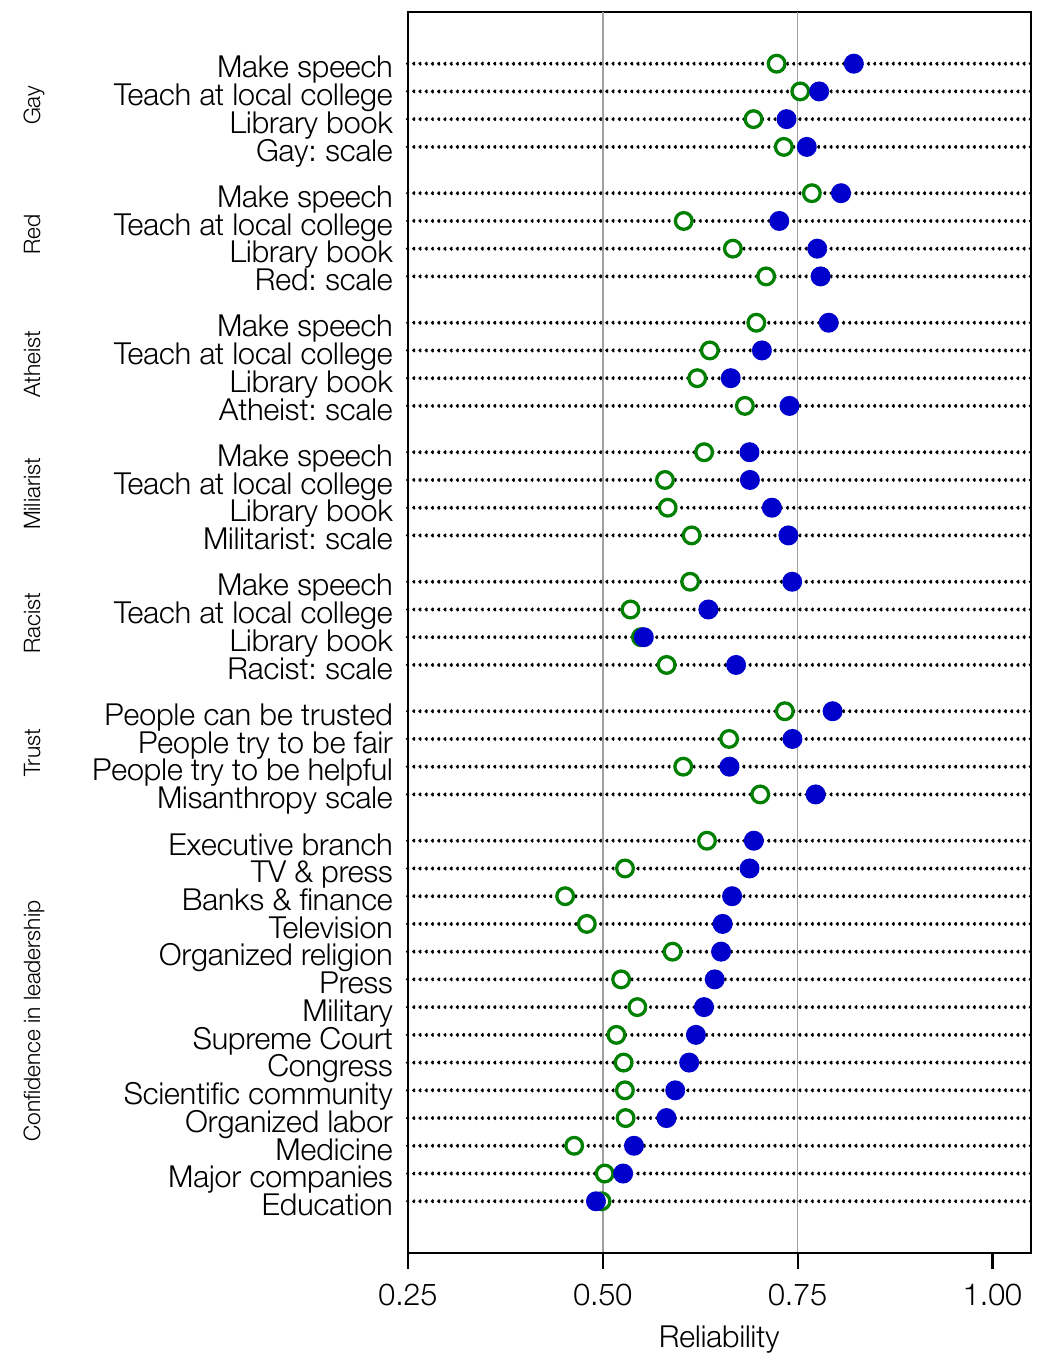
Figure 6: Reliability estimates for items about civil liberties, trust, and confidence in